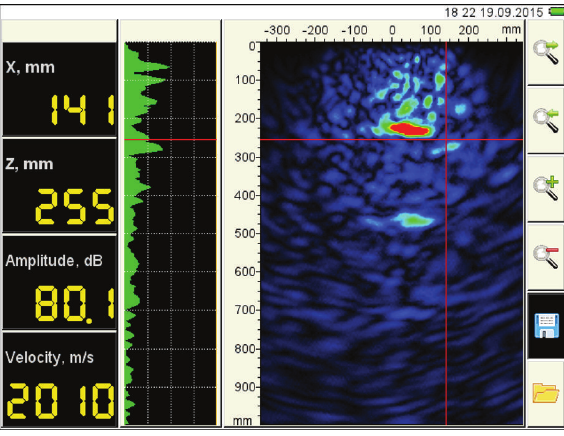
Figure 13: B-scan image from MIRA at the EF-V point in slab S1.